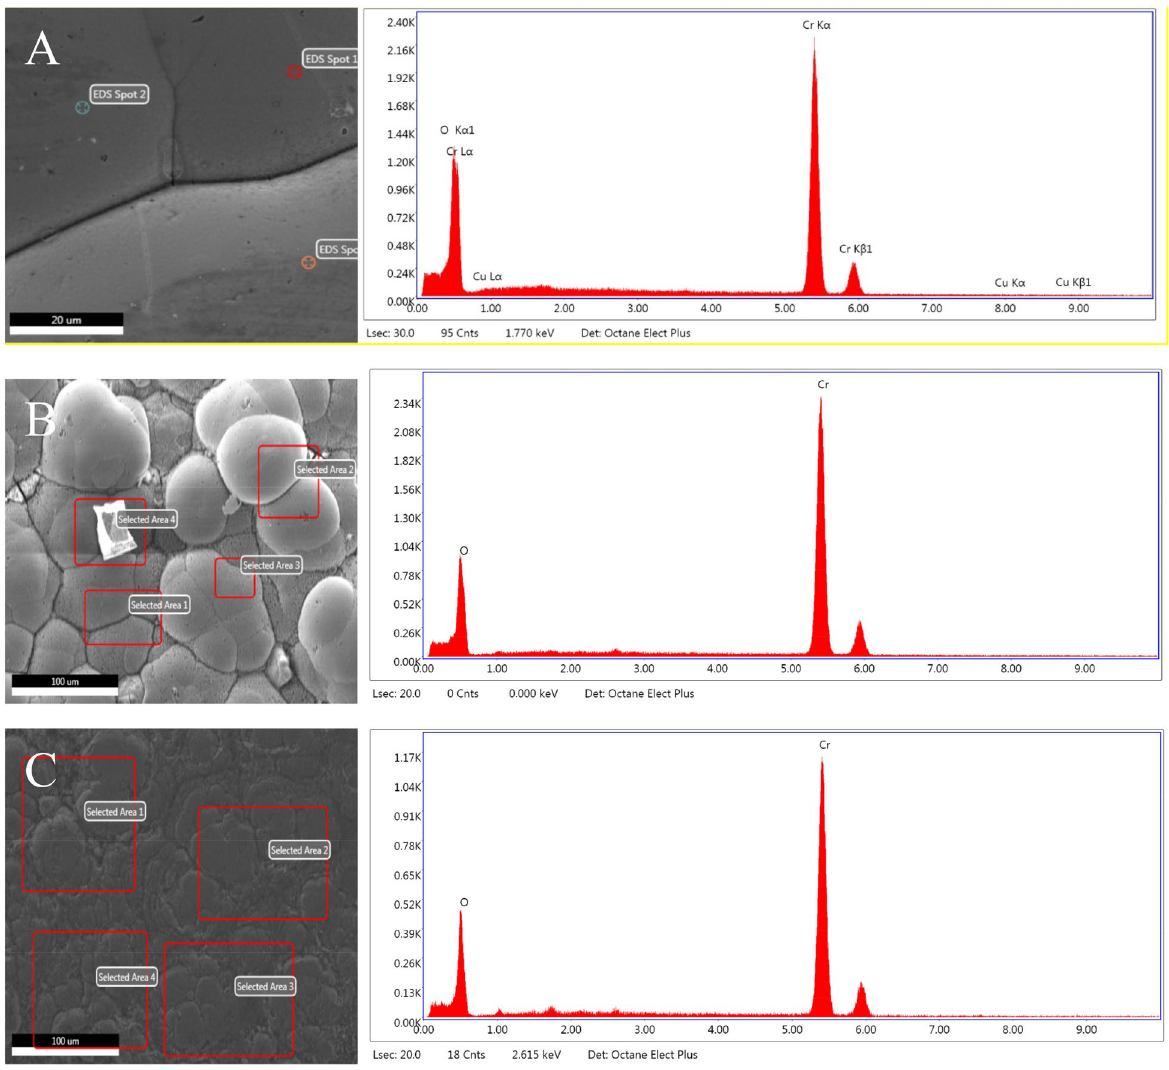
Figure 4. Scanning electron microscope (SEM) image and the energy dispersive X-ray analysis (EDAX) spectra for a representative electroplated Cr(III) target with a ( A ) Cu backing, ( B ) Au backing ( C ) Au backing after